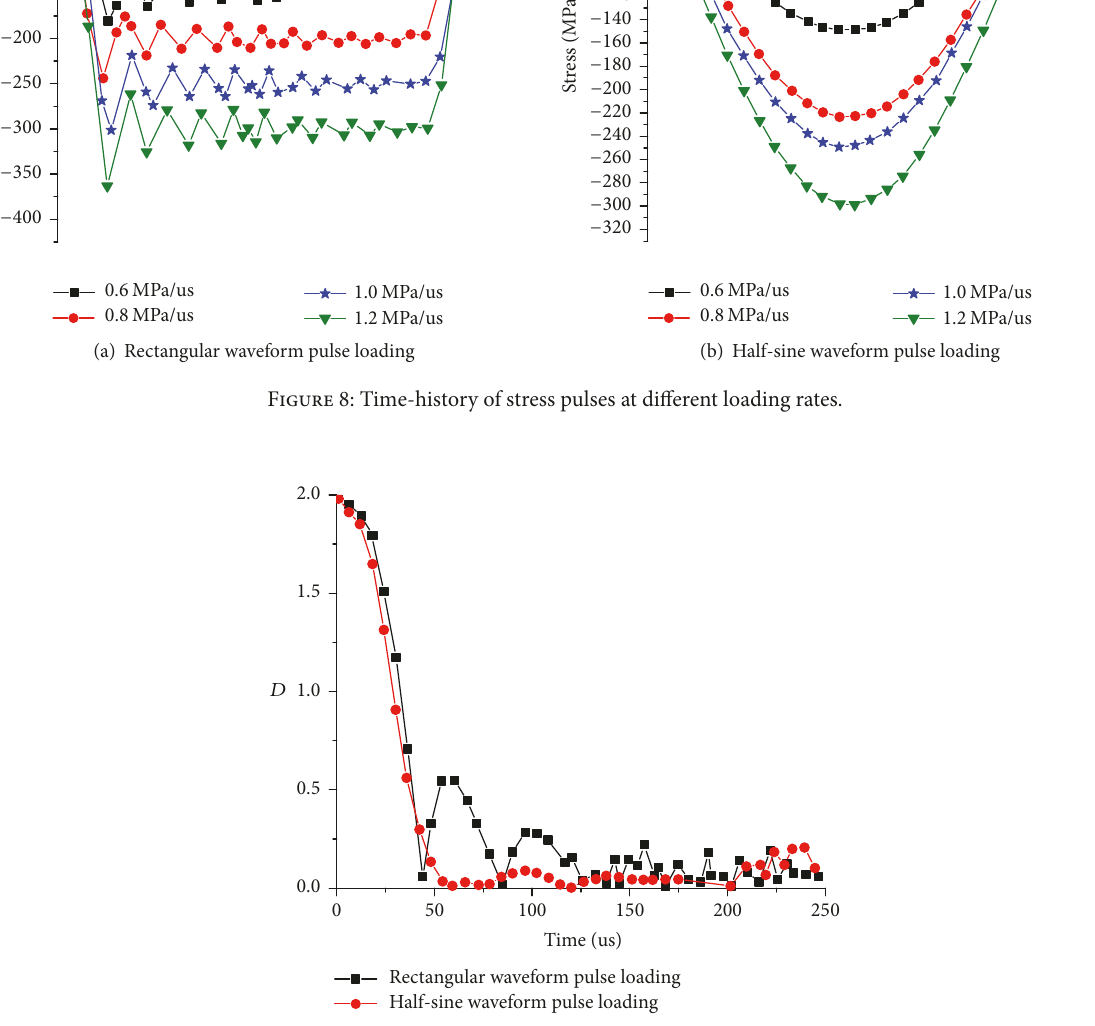
Figure 9: Variation curve of stress equilibrium equations factor (the diameter is 50 mm, and the length-diameter ratio of specimen is 1).